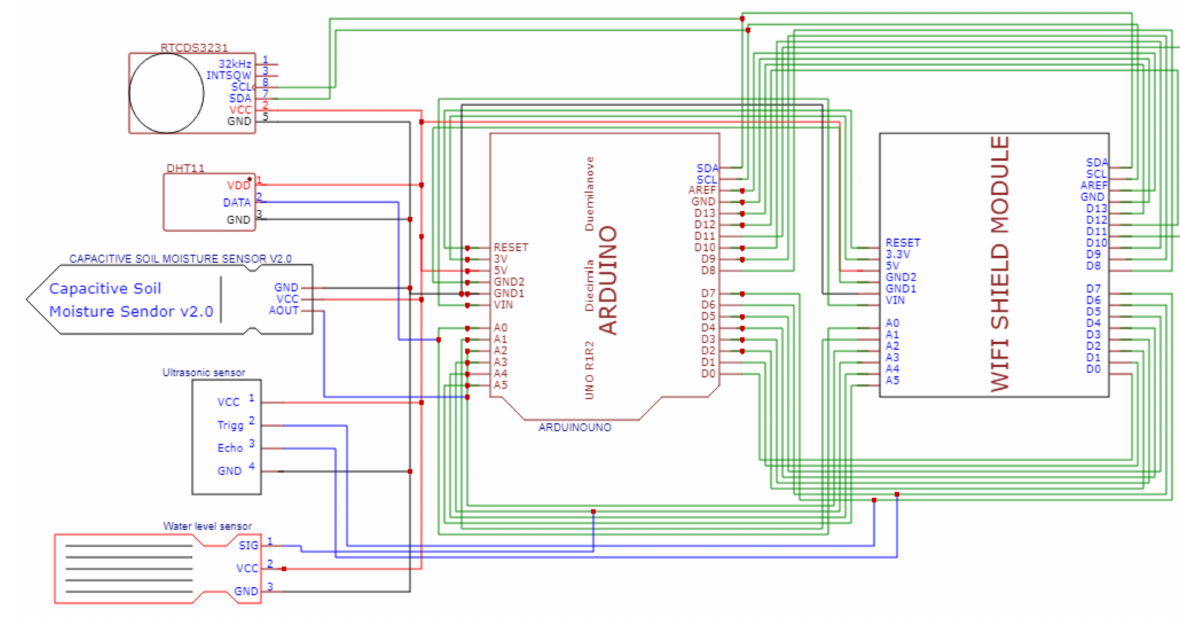
Figure 4. The schematic diagram of the circuit connection of the